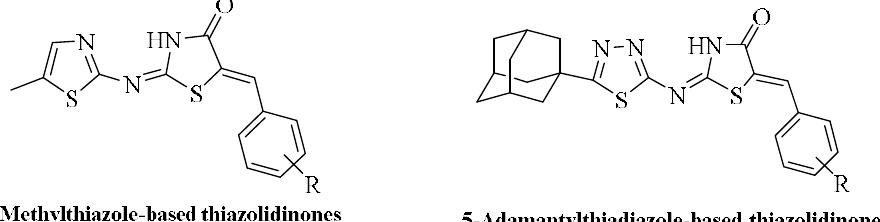
Figure 2. 5-methylthiazole-based thiazolidinones and 5-adamantylthiadiazole-based thiazolidinones.